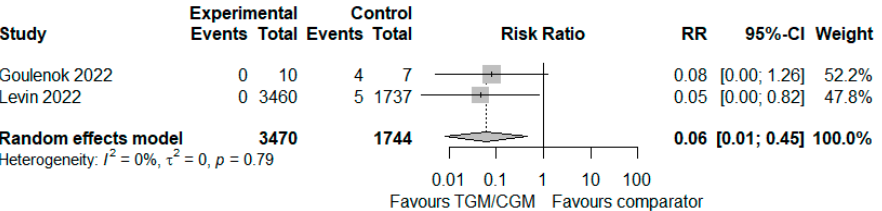
Figure 12. Proportion of patients who experienced severe COVID-19 (TGM/CGM vs. comparator). CI, confidence interval; RR, risk ratio; TGM/CGM, tixagevimab/cilgavimab.